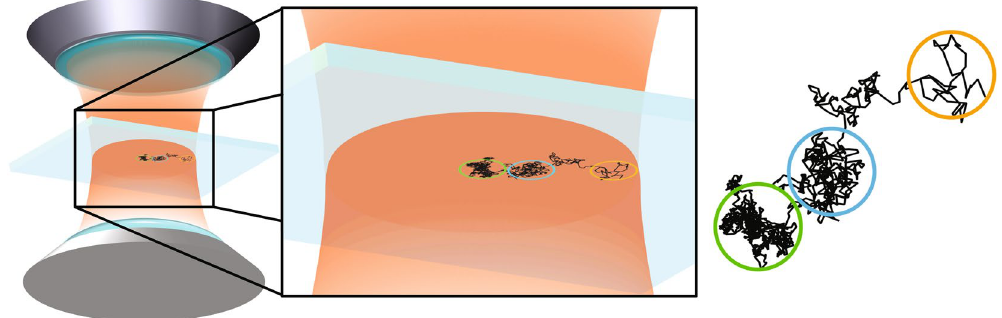
Figure 1. Diffusion of a particle trapped by optical tweezers. A schematic illustration of the position-dependent diffusion coefficient for a particle trapped by optical tweezers. The black kinky line is produced by connecting the positions of the bead falling into the trap. The colored circles with equal diameter are drawn at various radial distances from the center of the trap. The number of the data points inside each circle correlates with the diffusion coefficient. Thus, the larger the number of the data points, the lower is the diffusion coefficient. At the center (green circle) the particle possesses a small diffusion coefficient, whereas at larger radial distances (orange circle) it has higher diffusion